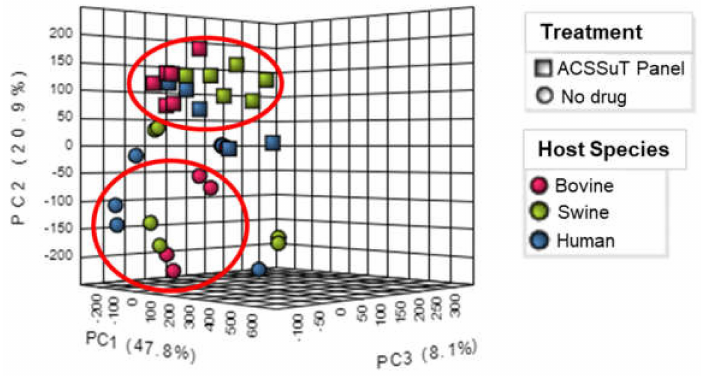
Figure 1. PCA chart derived from two–way ANOVA showing clustering of samples by drug